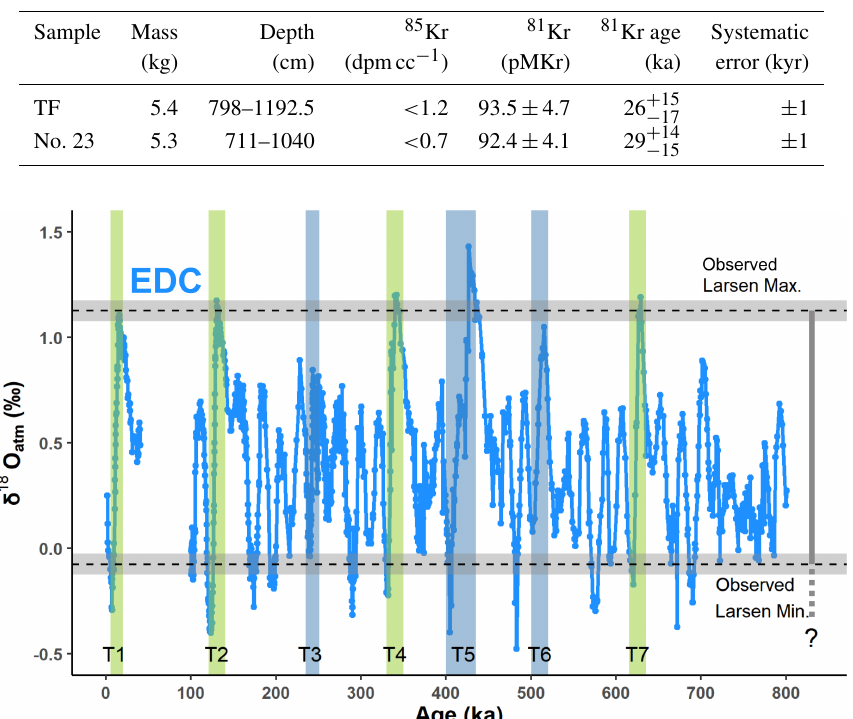
Table 2. Results of 81 Kr and 85 Kr analysis. Errors in the fifth to seventh column have a 1 σ confidence level, whereas upper limits in the fourth column have a 90% confidence level. The 81 Kr age in the sixth column is given with the statistic error due to atom counting. The systematic error in the 81 Kr age in the seventh column is due to the uncertainty in the half-life of 81 Kr (229 ± 11kyr). pMKr: percent modern krypton;